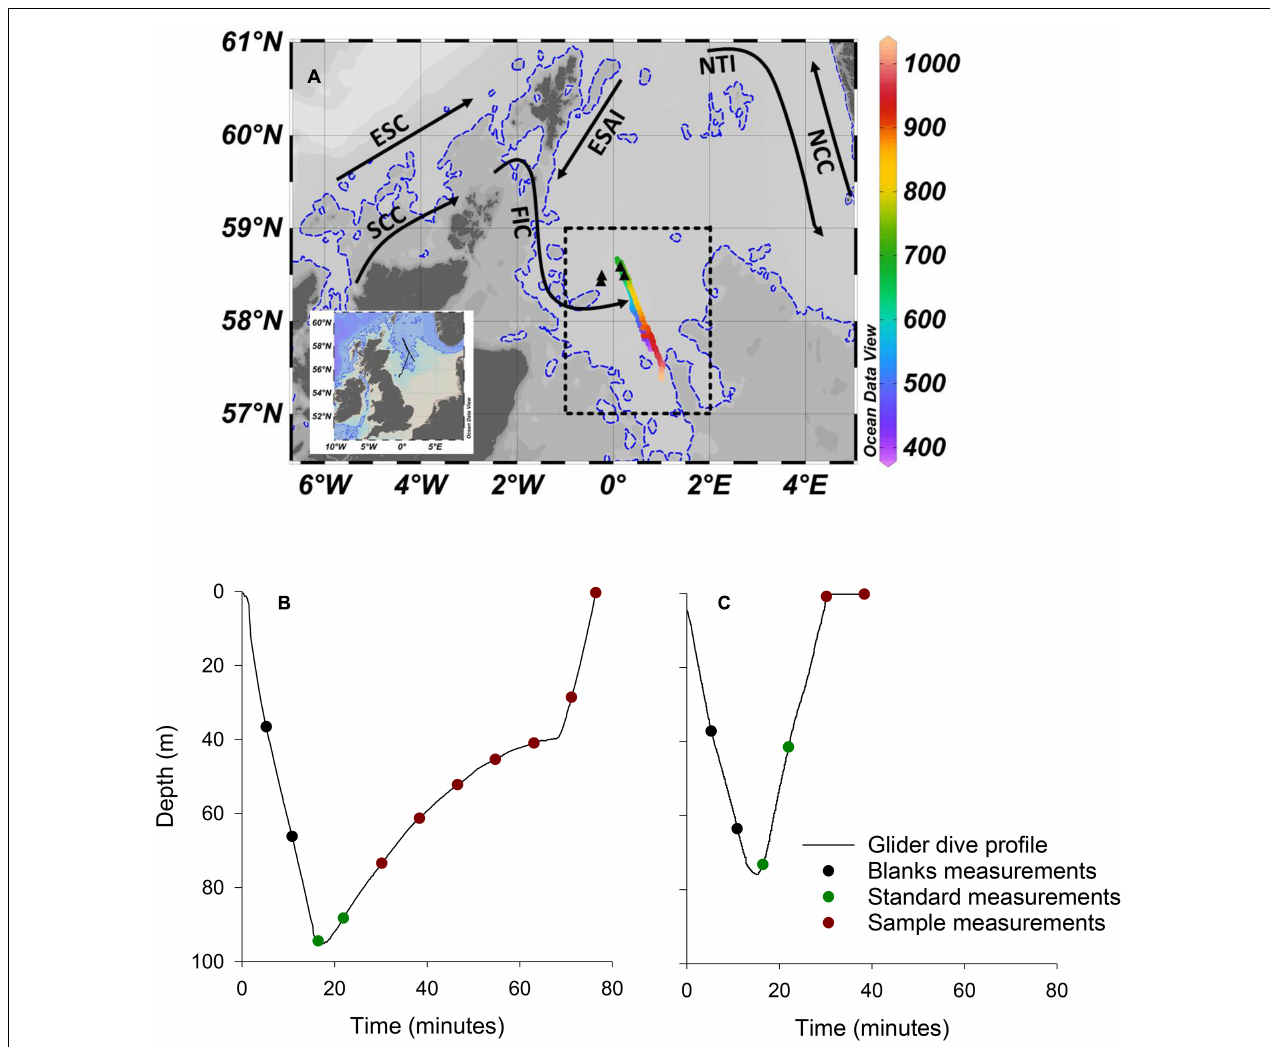
FIGURE 2 | Deployment location and dive profiles. (A) Map of the study area with complete Seaglider track shown on inset map. The colour bar represents the dive number. Dives < 379 and > 1,034, which included minimal PO 43 − sampling as the glider was piloted toward deployment and recovery locations, respectively, and are not shown on main figure. Transect 1 included dives numbered 390–690. Transect 2 included dives numbered 691–1,034. The dashed rectangle encompasses the area of the North Sea Biogeochemical Climatology used for comparison (see text for details). Black triangles are the location of 4 RV Heincke sampling stations used for comparison (see text for details). Dashed blue line is the 100 m isobath. Black arrows are approximate paths of the Fair Isle Current (FIC), East Shetland Atlantic Inflow (ESAI), Scottish Coastal Current (SCC), European Slope Current (ESC), Norwegian Trench Inflow (NTI), and Norwegian Coastal Current (NCC). (B)